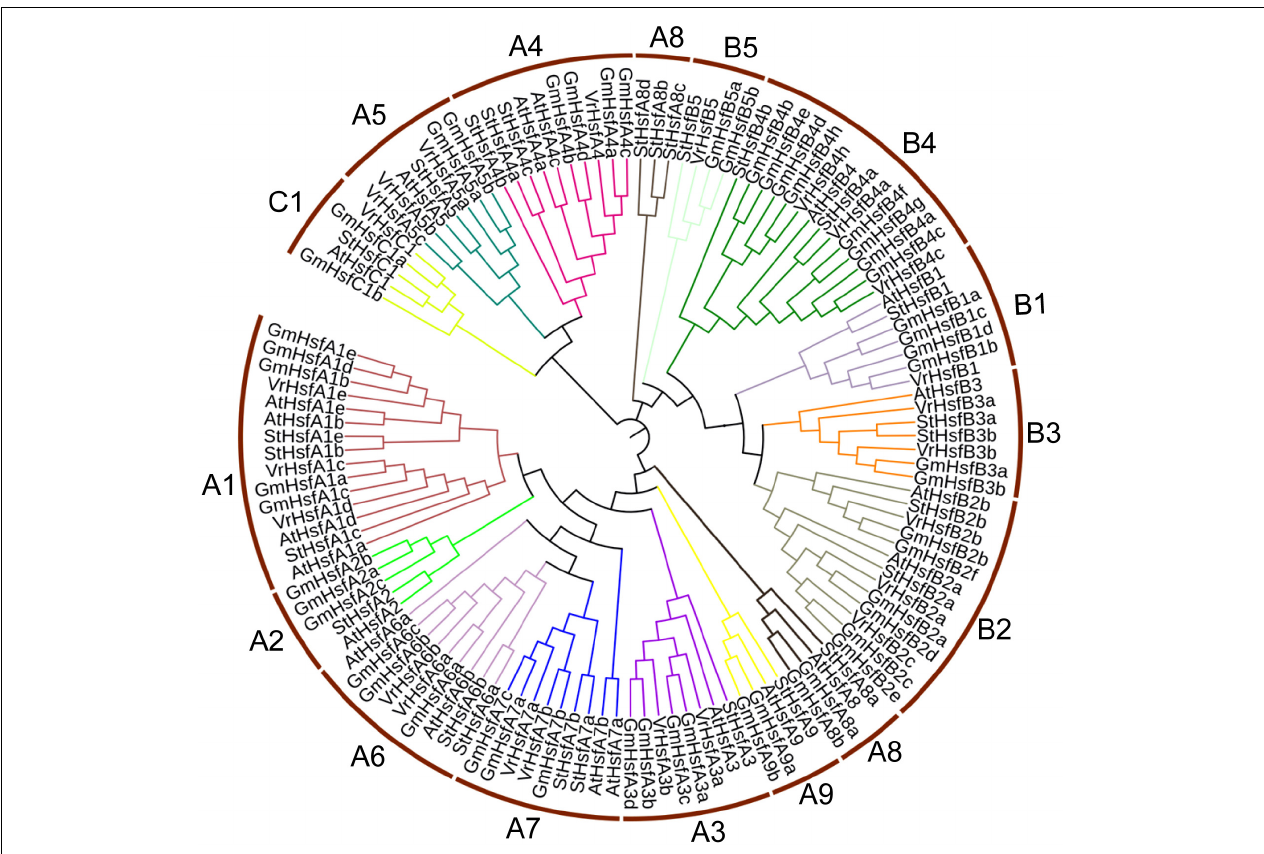
FIGURE 1 | Evolutionary relationship analysis of VrHsf proteins. The N-proximal regions (from the start of the conserved DBD domain to the end of the HR-A/B region) of Hsf proteins from mungbean, soybean, Arabidopsis and potato were used to construct the phylogenetic tree using MEGA 6.0 with the Neighbor-Joining method.